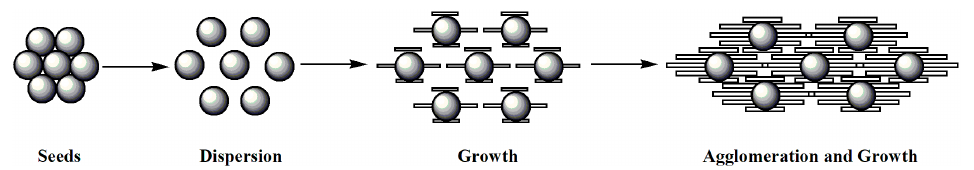
Figure 8. Agglomeration and growth of particles.